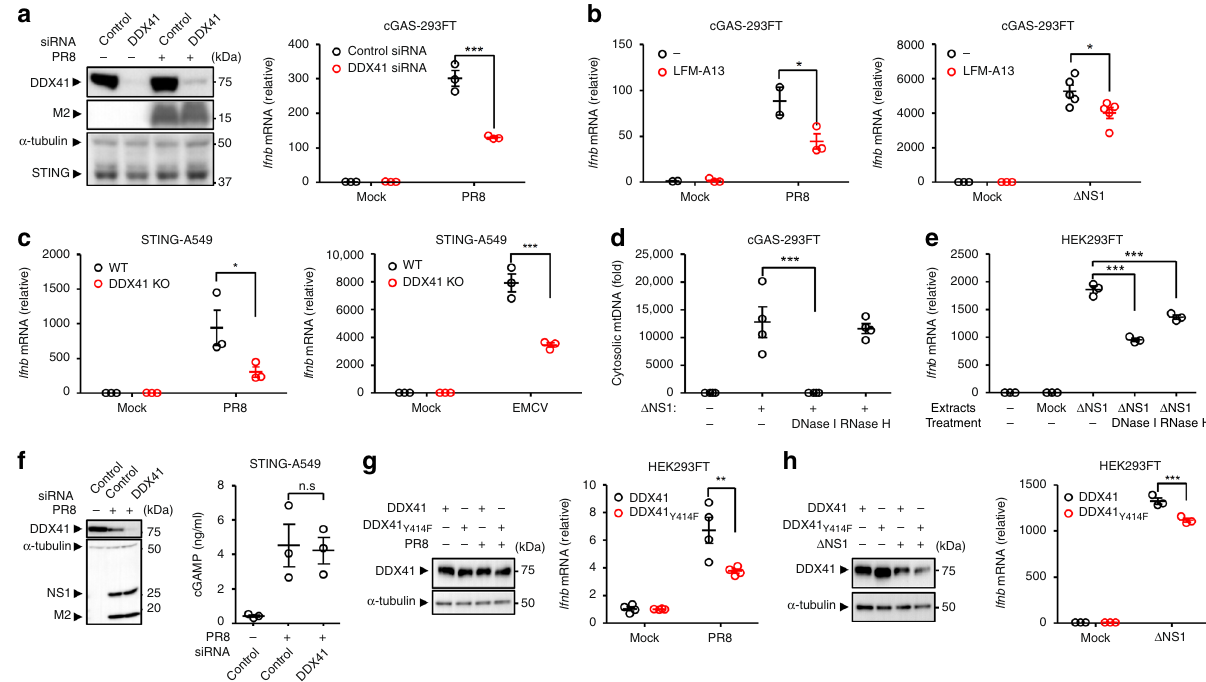
Fig. 5 In fl uenza virus stimulates DDX41-dependent IFN- β gene expression. a cGAS-293FT cells transfected with siRNA targeting DDX41 or control siRNA were infected with in fl uenza virus for 24 h. Cell lysates were collected and blotted using the indicated antibodies (left panel). IFN- β mRNA levels were assessed by quantitative PCR with β -actin as an internal control (right panel). b , c cGAS-293FT cells were infected with WT (left panel) or Δ NS1 in fl uenza virus (right panel) for 24 h in the presence or absence of LFM-A13 (100 μ M) ( b ). WT or DDX41-de fi cient STING-A549 cells were infected with PR8 (left panel), or EMCV (right panel) for 24h ( c ). IFN- β mRNA levels were assessed by quantitative PCR with β -actin as an internal control. d Pure